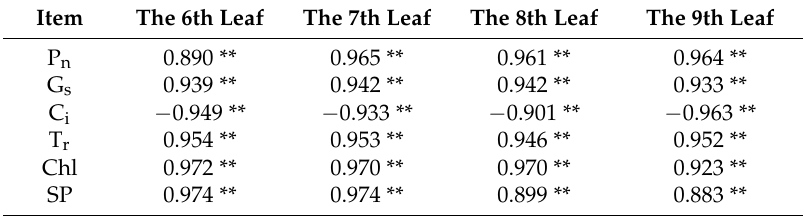
Table 4. Correlation coefficients between yield and photosynthetic parameters of different functional leaves in Tartary buckwheat. Item The 6th Leaf The 7th